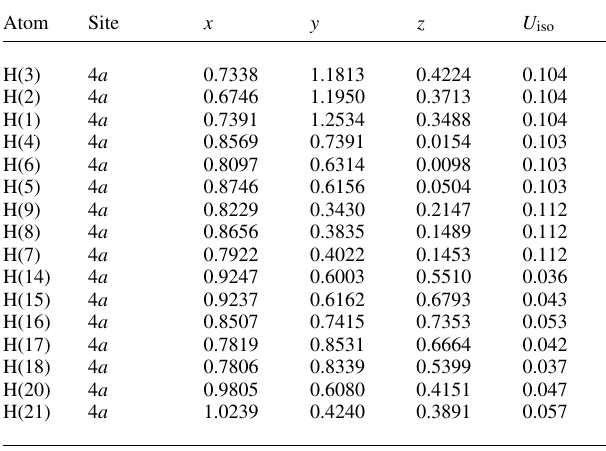
Table 2. Atomic coordinates and displacement parameters (in Å 2 )